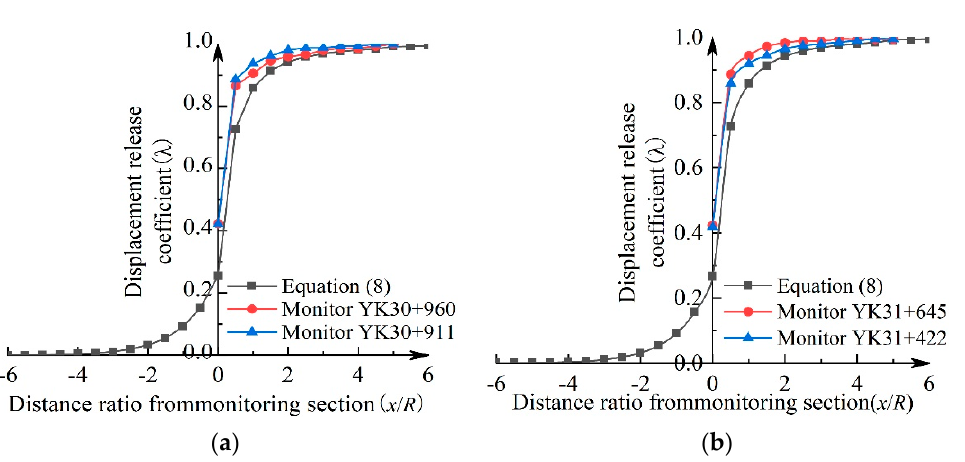
Table 2. Fitting parameters of surrounding rock.